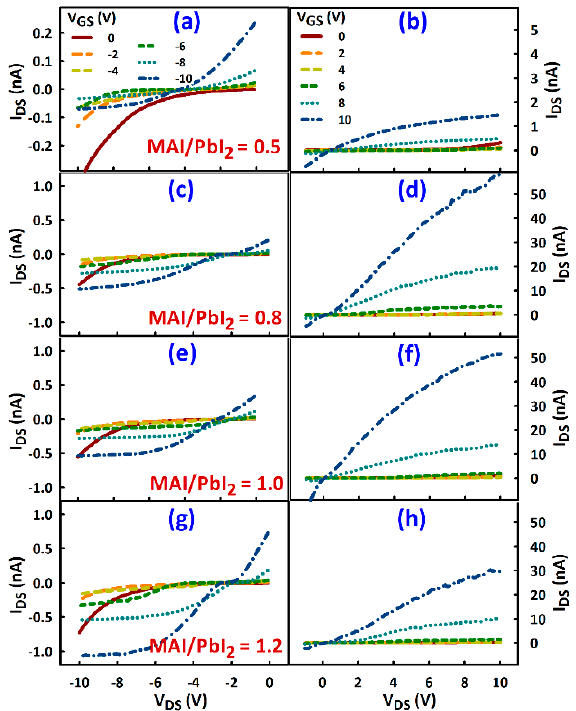
Figure 6. P-type and n-type output characteristics (I D vs. V DS plots) of a MAPbI 3 TFTs with MAI / PbI 2 ratio of ( a, b ) 0.5, ( c, d ) 0.8, ( e, f ) 1.0, and ( g, h ) 1.2. W = 100 μ m and L = 50 μ m.